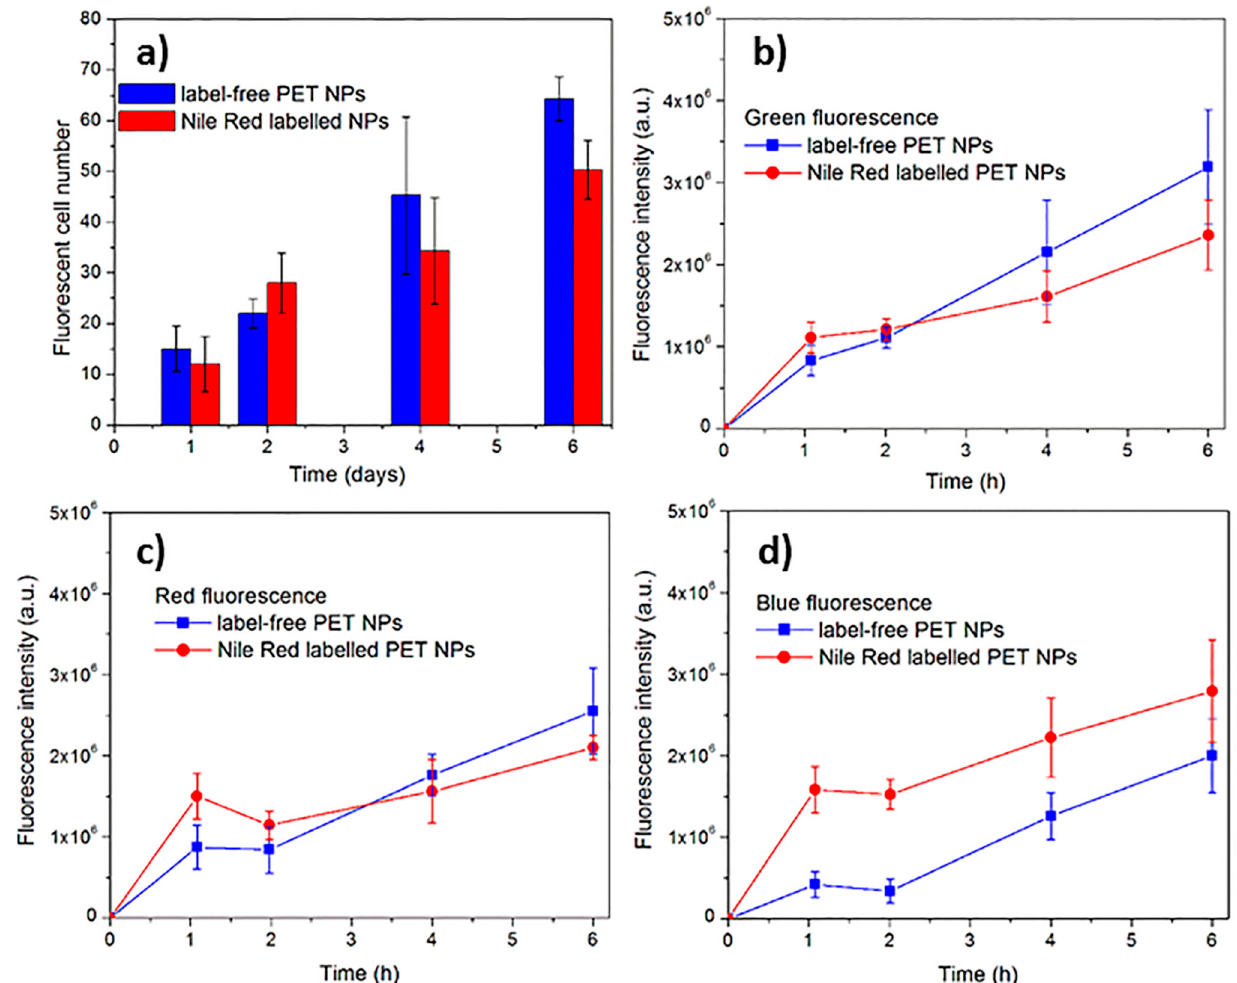
Figure 7. ( a ) Number of M. galloprovincialis hemolymphatic cells internalizing nanoparticles observed during the exposure to label-free PET NPs (10 mg/L) or Nile-red-labeled PET NPs (10 mg/L) for a time span of 6 h; ( b – d ) fluorescence intensity during in vitro exposure of M. galloprovincialis hemocytes to label-free and Nile-red-labeled NPs (10 mg/L) under the green excitation at 485 nm ( b ), the red excitation at 523 nm ( c ), and blue excitation at 360 nm ( d ).